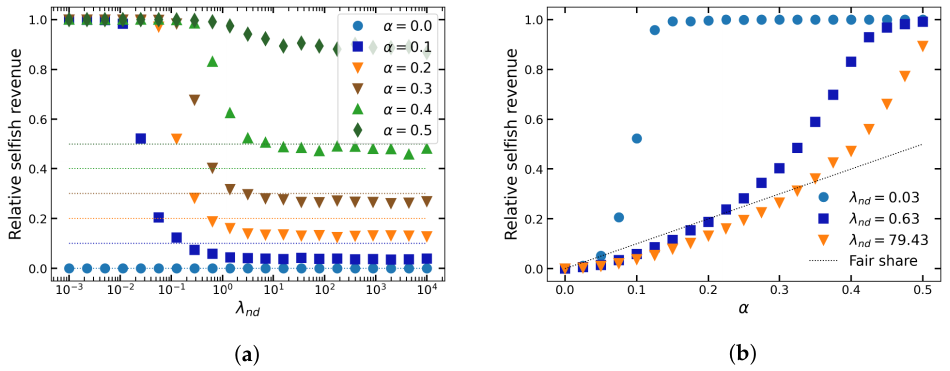
Figure 2. Relative selfish revenue as a function of: ( a ) network latency ( λ nd ) and ( b ) selfish hashing power ( α ).